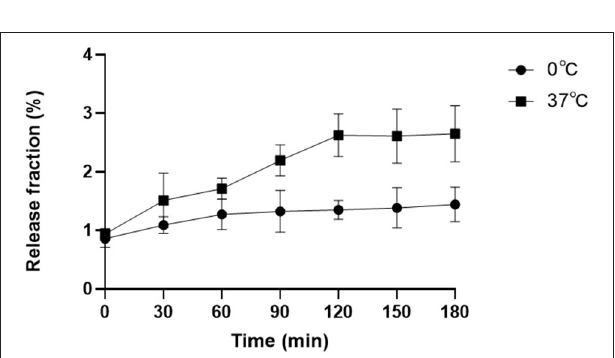
FIGURE 2 | Post-labeling stability analysis. The released radioactive fraction of 18 F-VS-RBCs when incubated in plasma at 37 ◦ or 0 ◦ C for 0–180min ( n = 4).